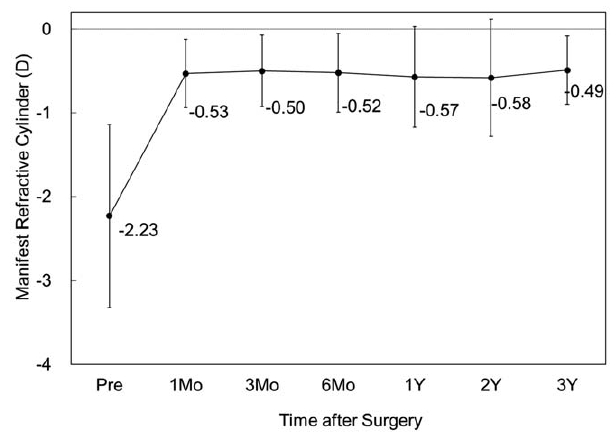
Figure 5. Time course of manifest refractive cylinder after toric implantable collamer lens implantation. D=diopter, M=month,